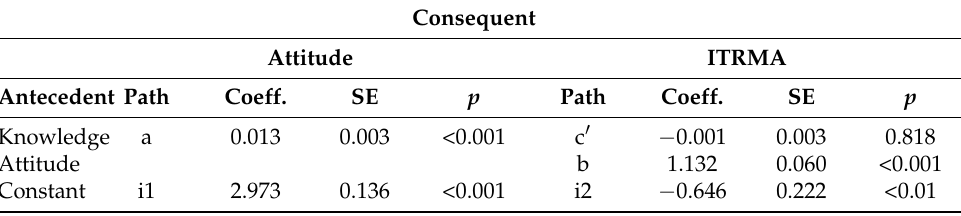
Table 3. Results of mediation tests via process macros. ITRMA: Intention to Take Responsible Marine